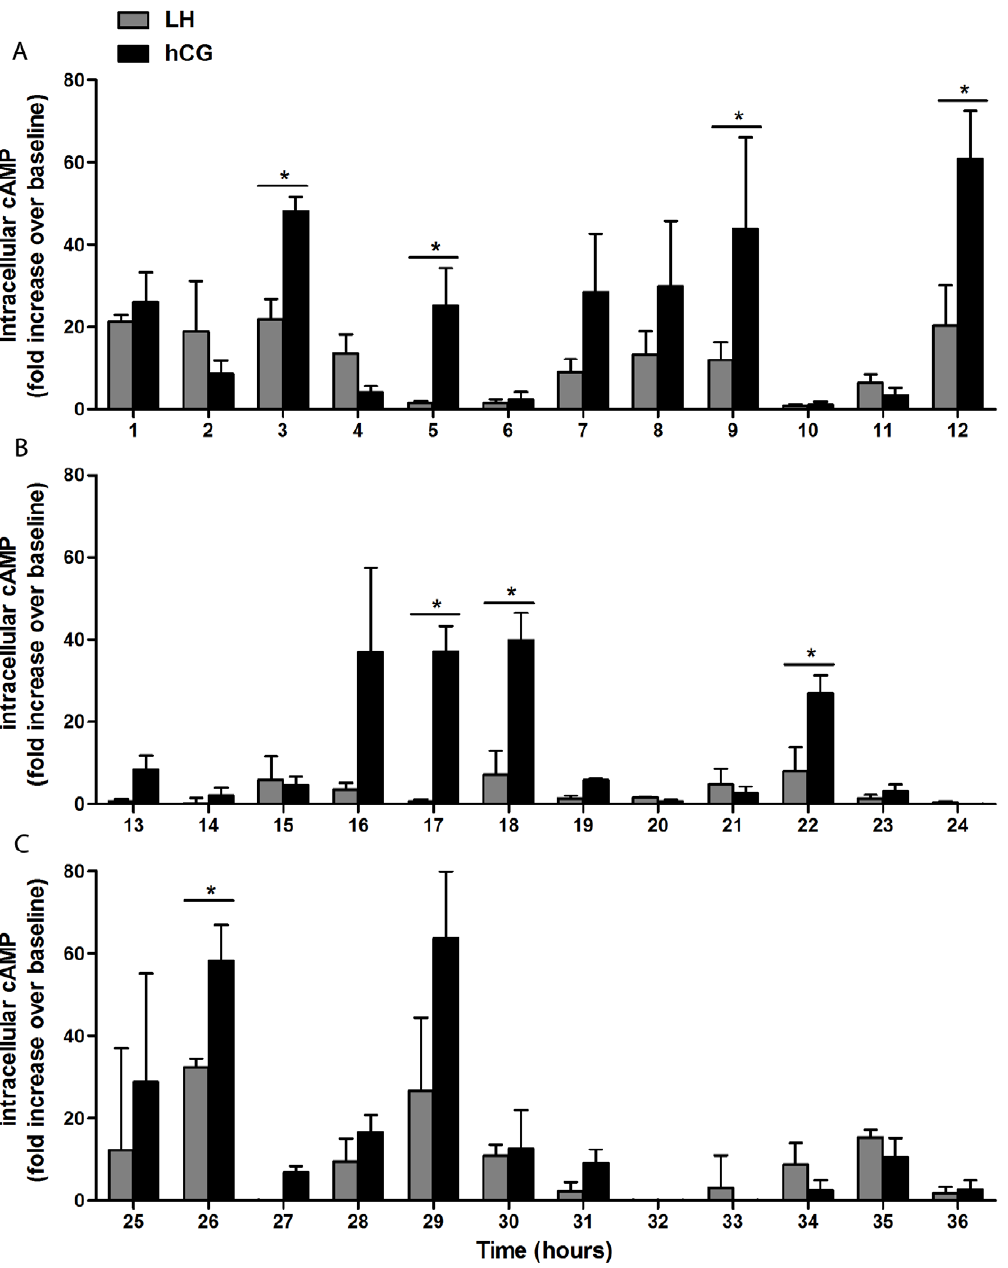
Figure 3. Long-term kinetics of intracellular cAMP production in hGLC continuously exposed to r-hLH or r-hCG. hGLC were cultured in the presence IBMX (500 m M) under continuous stimulation by r-hLH (500 pM) or r-hCG (100 pM) for up to 36 hours: ( a ) 0–12 hours, ( b ) 13–24 hours, ( c ) 25–36 hours. Results are means 6 SEM (n=3). Asterisks indicate significant differences between hCG and hLH at the given time point (n=3; t-test ; p ,